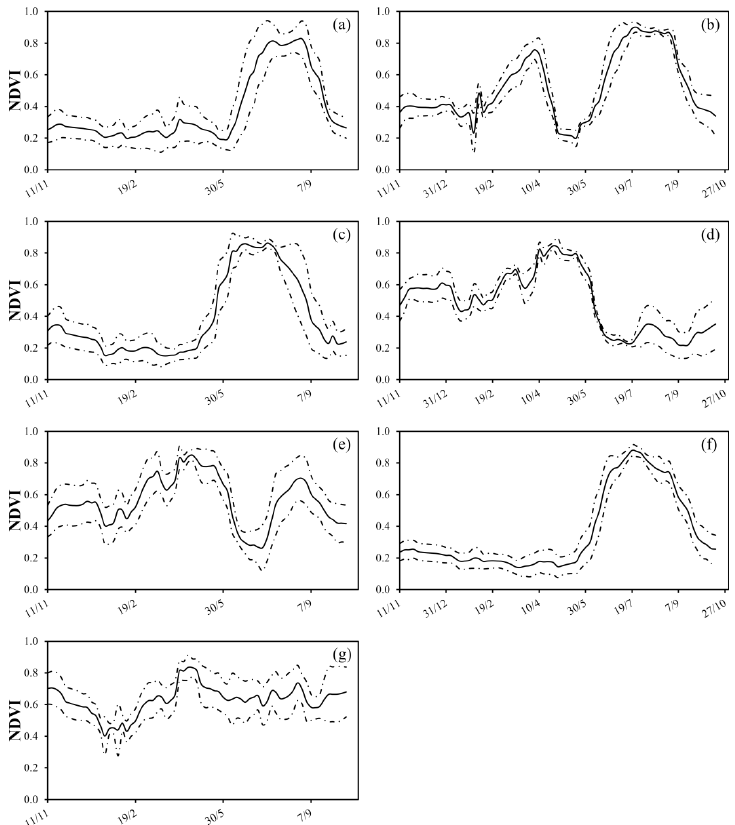
Figure 6. ROIs’ average NDVI profiles throughout the 2019 season. Bold line represents mean profile; dotted lines are mean ± standard deviation profiles. ( a ) Soybean-100; ( b ) Soybean-101; ( c ) Corn-200; ( d ) Wheat-300; ( e ) Wheat-301; ( f ) Rice-400; ( g ) Meadow-500.